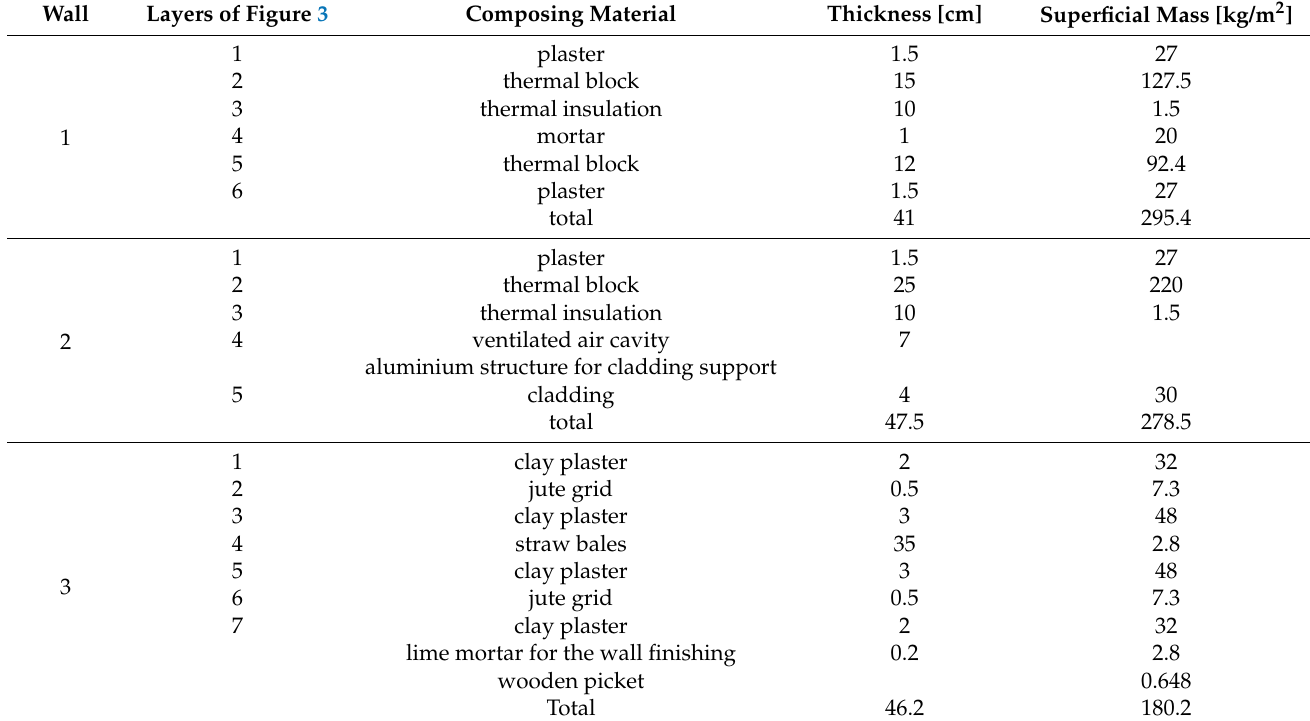
Figure 3. Wall-sample sections equipped with thermally insulating panels. Table 2. Dimensions and superficial mass for the three wall-composition samples